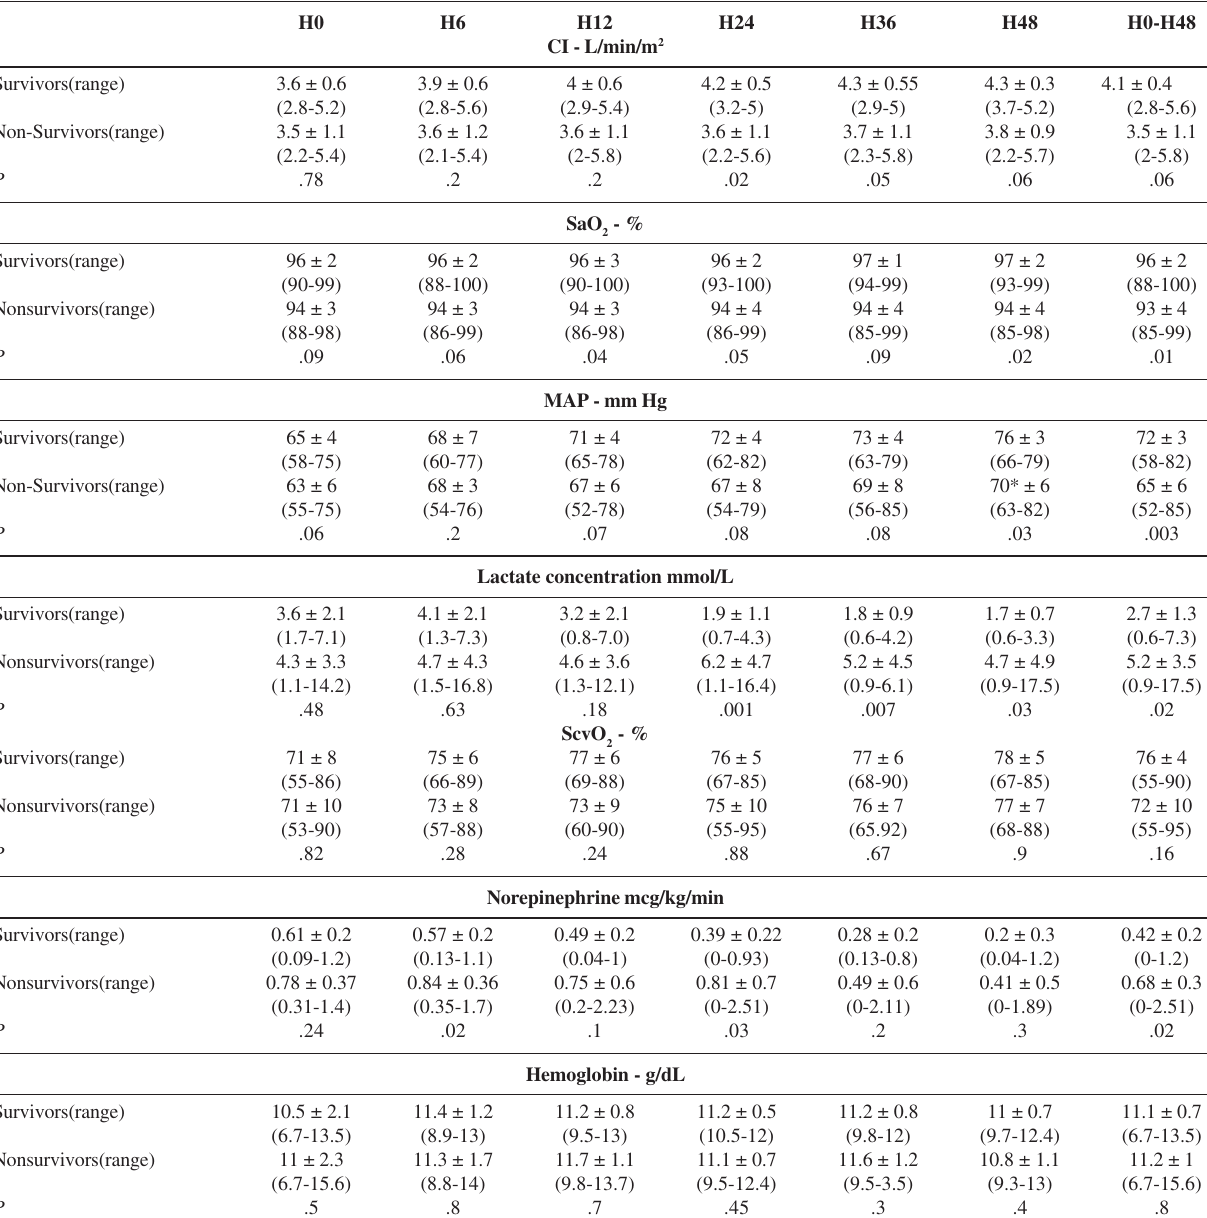
Table 3 - Target parameters in survivors and nonsurvivors: cardiac index (CI), arterial oxygen saturation (SaO arterial blood pressure (MAP), blood lactate concentration, oxygen central venous saturation (ScvO regimen, and hemoglobin concentration in survivors and nonsurvivors of the target